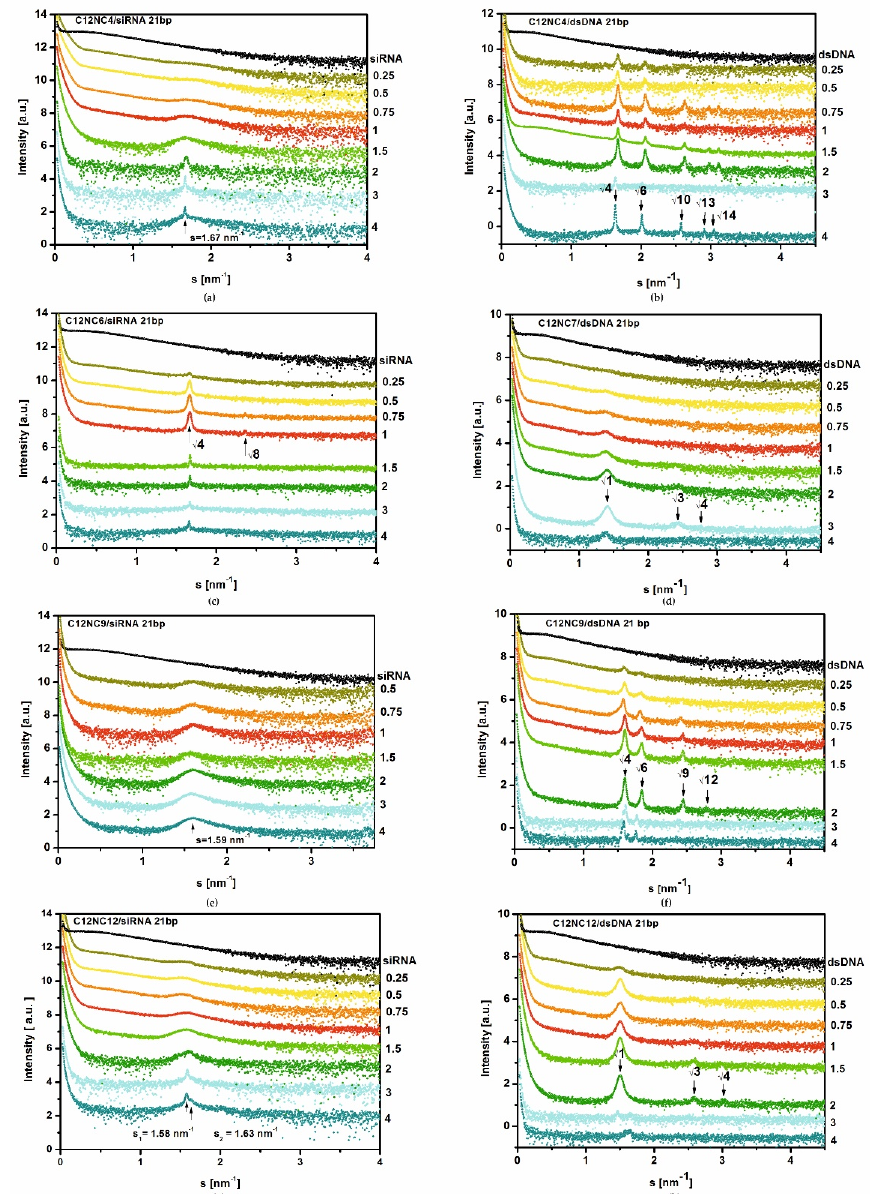
Figure 5. SR-SAXS curves recorded for selected mixtures of C12NCn with siRNA ( a , c , e and g ) and dsDNA ( b , d , f and h ) oligomers. Table 1. Analysis of SR-SAXS data and structural phases proposed for dsDNA–C12NCn and siRNA–